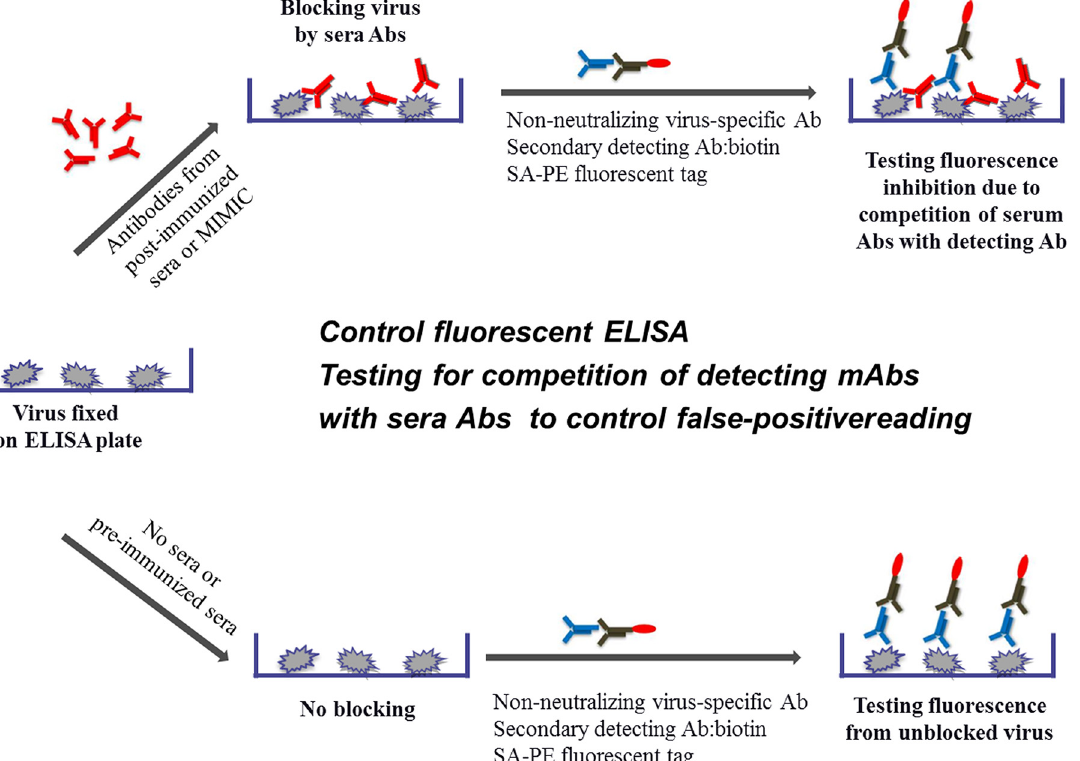
Fig 2. Schematic representation of Control ELISA to check for false positive effects in the fADI neutralization assay. Virus is added to ELISA plates instead of using target cells to check for any false positive readings. Addition of sera (upper arm) or no sera (lower arm) should produce similar reporter signals (fluorescence) indicating the absence or low level of competition of virus-specific labeling antibody with antibodies in test serum. The plates are read on the Synergy HT plate reader (BioTek) after applying the secondary detecting antibody and the fluorescent tag SA-PE. More details are in the